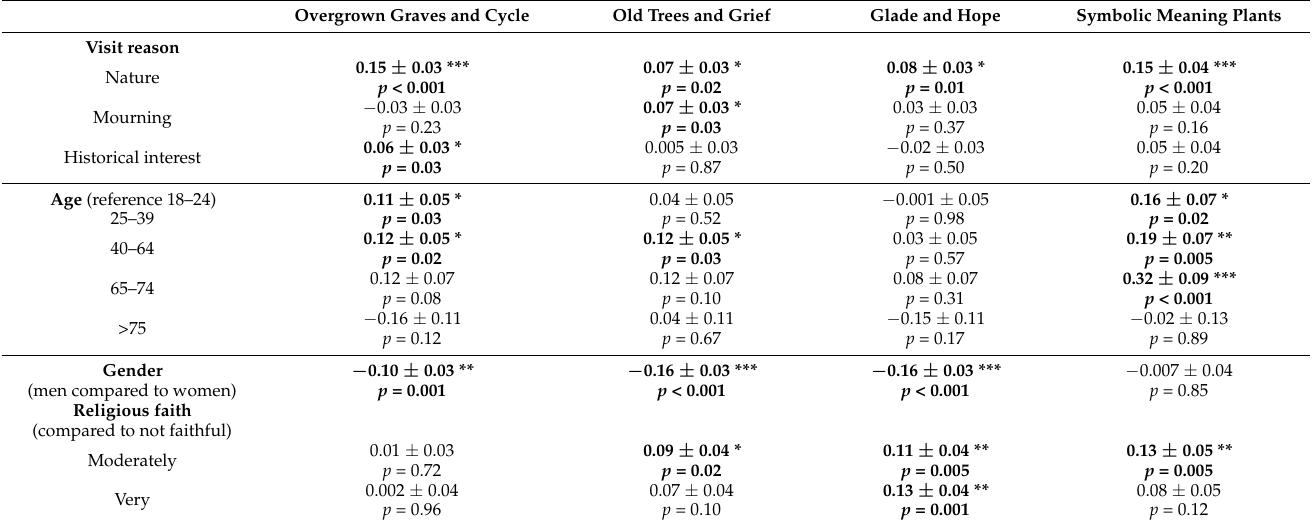
Table 3. Predictive potential of reason of cemetery visit and the sociodemographic factors of the respondents on comforting nature experiences shown in Figure 6. Significant results shown in